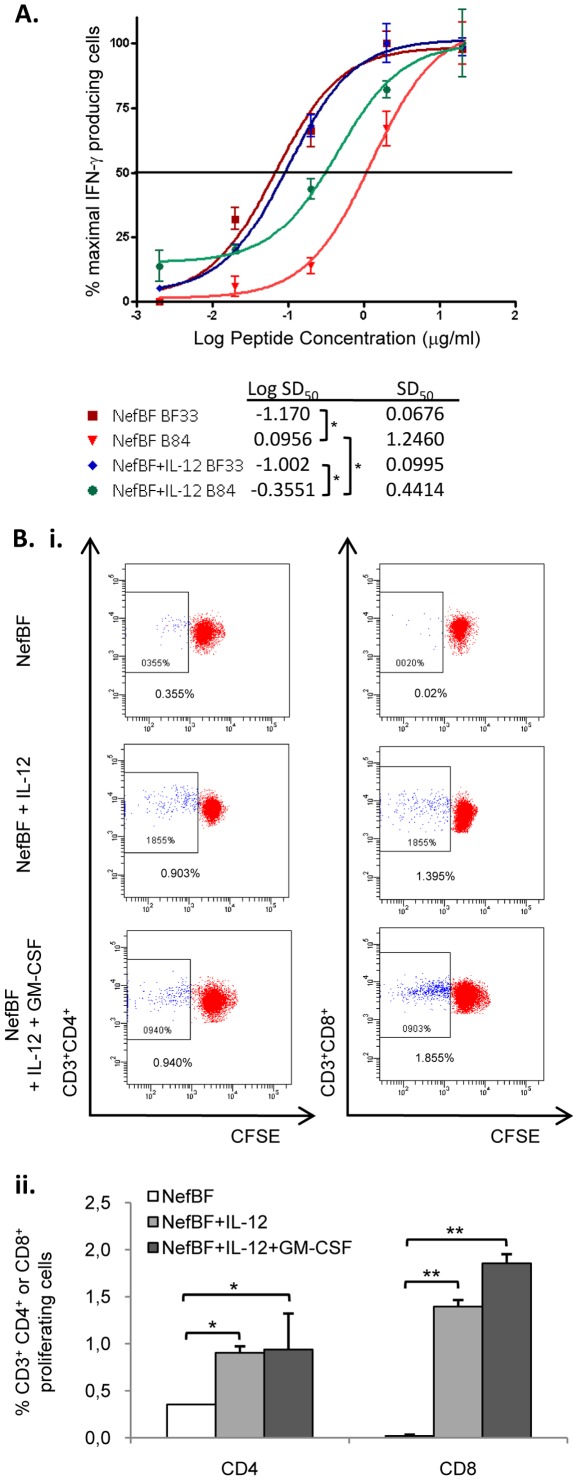
IL-12 and GM-CSF improved the quality of the cellular immune response.
A) Functional avidity of the BF33- and B84-specific T-cells: Groups of 4 mice received the immunization schemes depicted in Figure 1 for the group 1 (NefBF alone) and group 2 (plus IL-12 during the priming phase). Nine days after the MVA boost, T- cell avidity against BF33 and B84 peptides was evaluated using serial dilutions of the peptides. Peptide concentrations used ranged from 20 to 0.002 µg/ml. SD50: sensitizing dose of peptides required to yield 50% maximal T-cell triggering of IFN-γ production. B) Spleen cells from the indicated group were evaluated for their proliferative capacity against the BF33 peptide, and the identification of the specific T-cell subset was performed. For this, cells were dyed with CFSE and stimulated with BF33 peptide during 5 days and then staining with surface antibodies was performed (CD3, CD4 and CD8). i- Representative dot plots. Numbers inside the graphs represent the average values for duplicated samples. ii- Bars represent the average of duplicated samples plus SD. Background values obtained in cell-cultures stimulated with RPMIc, were subtracted in each case. T test was applied, *p<0.05, * * p<0.005.